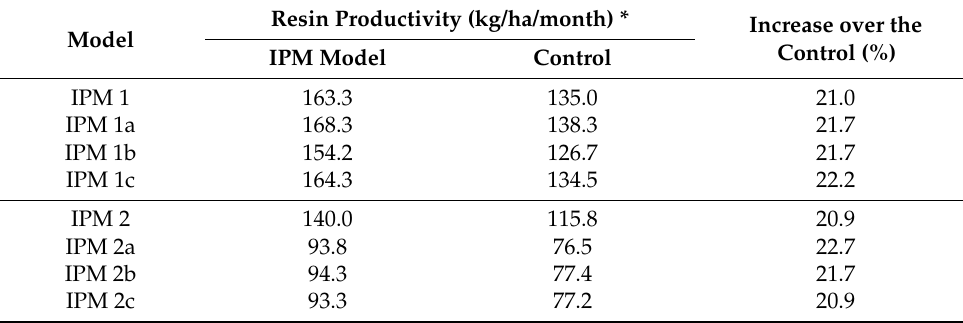
Table 9. The effect of the integrated pest management models on resin